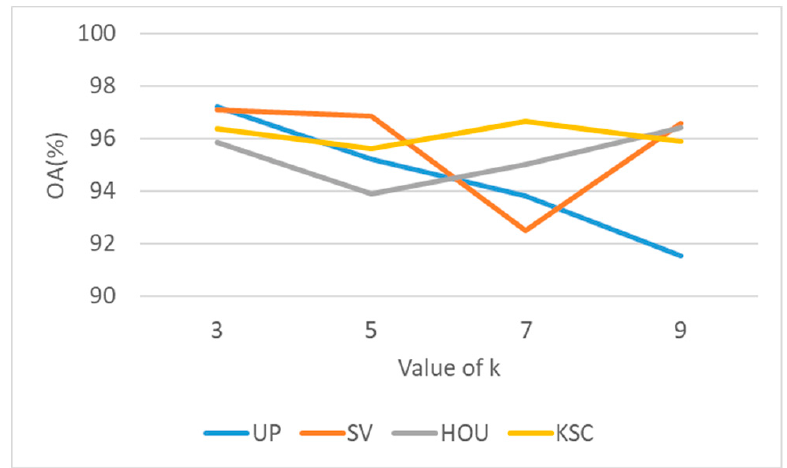
Figure 17. OAs with different values of 𝑘 on four datasets.